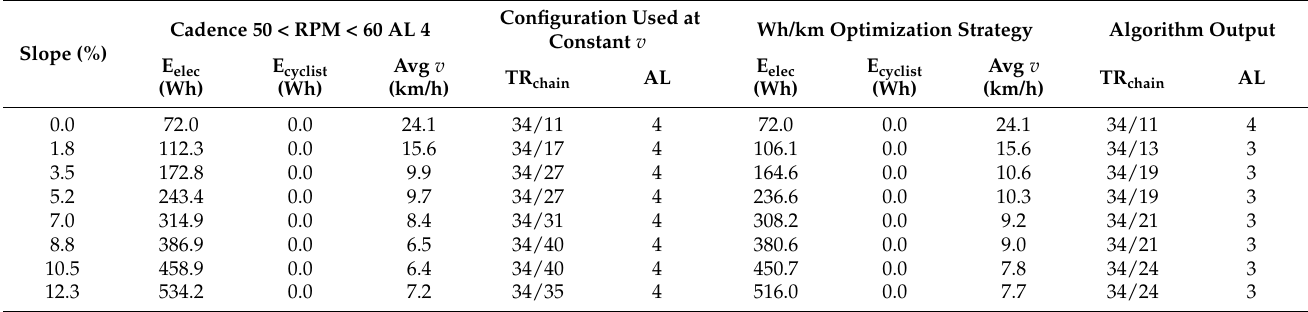
Table 4. Performance of strategies two and one under e-bike power alone (E stands for energy, v stands for speed, TR chain stands for chain transmission ratio and AL stands for assistance level).